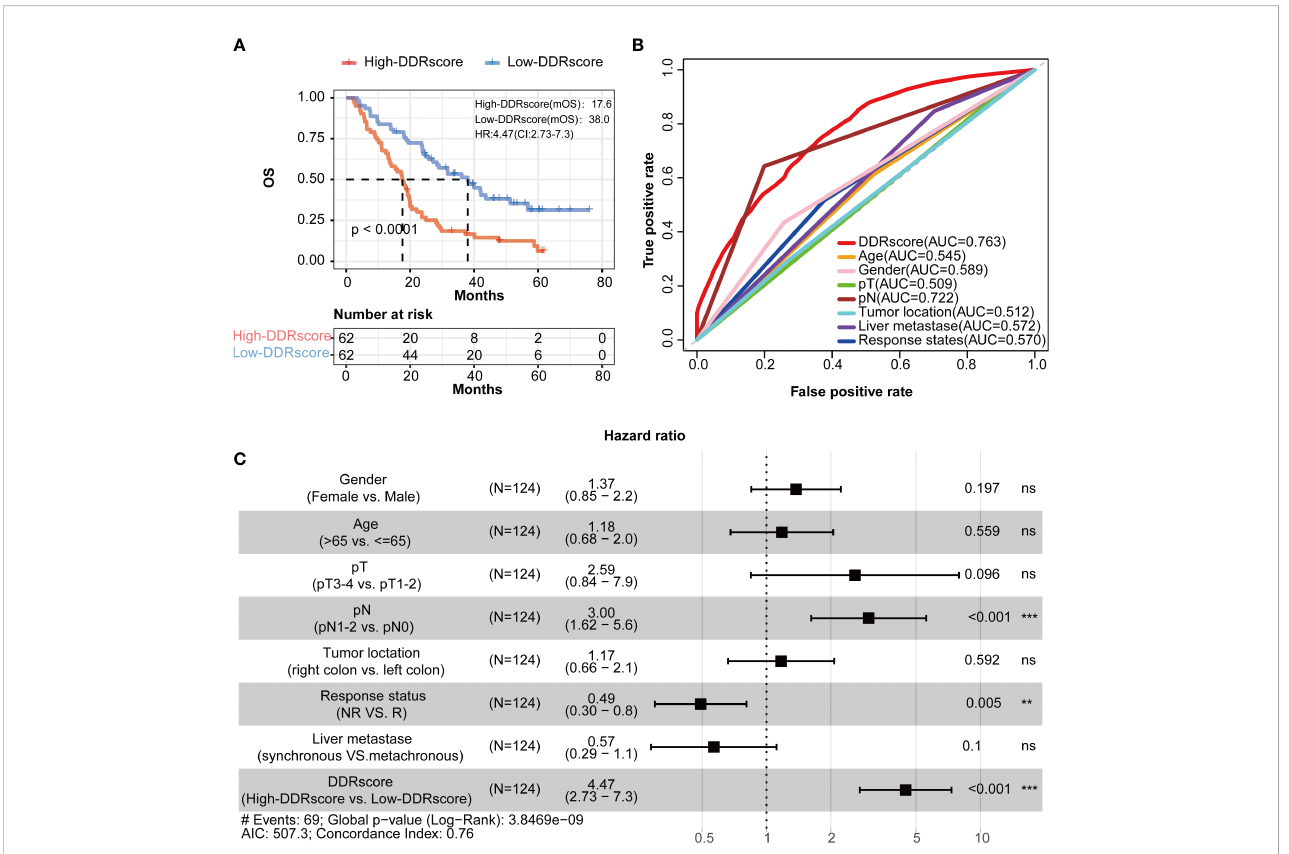
FIGURE 4 Identi fi cation of four-DEDG with prognostic value in metastatic colorectal cancer (mCRC) patients. (A) Kaplan – Meier analytical evaluation of the prognostic values of DDRscore. (B) Time-dependent receiver operating characteristic curves for the prognostic model based on DDRscore in the training cohort. (C) The multivariate Cox regression analysis of DDRscore and clinical features regarding prognostic value. Clinical features: gender, age, pT, pN, and liver metastase, tumor location, and therapy response. * Indicates P < 0.05, ** Indicates P <0.01, ***Indicates P <0.001, ns indicates no signi fi cant